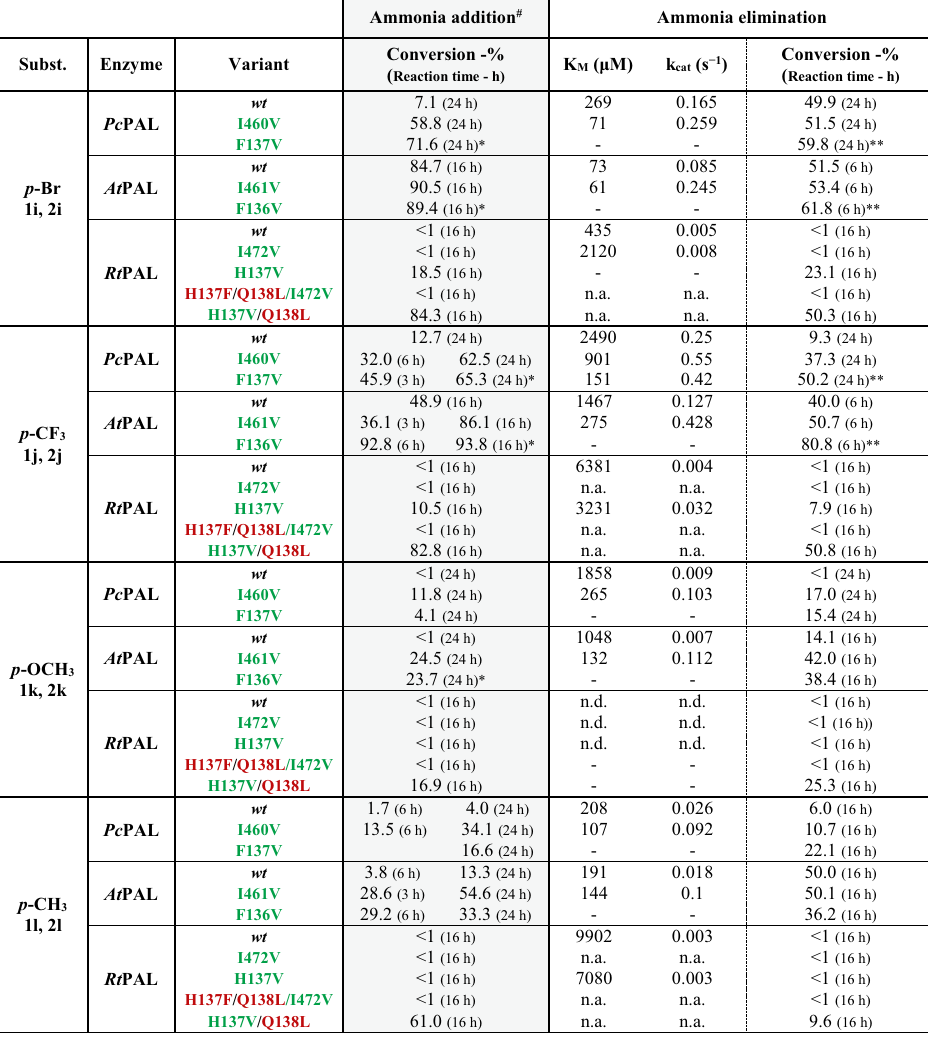
Table 3. Activity assessment of the different PAL variants within the ammonia addition and ammonia elimination reactions of para -substituted cinnamic acids 2i – l and rac -phenylalanines 1i – l , respectively. n.d. not determinable, during enzyme kinetics the non-linear range of the Michaelis–Menten curve was not obtained using substrate concentration allowed by the solubility of the tested compounds; n.a. no activity detected; “-” no determination/measurement was performed. # During the ammonia additions the enantiomeric excess of the obtained l-phenylalanine analogues was also monitored, in all cases ee > 99% have been obtained, with marked exceptions. * 1 . In case of 2i: Pc PAL F137V variant provided l-1i with ee = 97%; At PAL F136V variant provided l-1i with ee = 93%; 2 . in case of 2j : Pc PAL F137V variant provided l-1j with ee = 82%; At PAL F136V variant provided l-1j with ee = 83%; 3 . in case of 2k : At PAL F136V variant provided l-1k with ee = 97%. **During the kinetic resolution-type ammonia eliminations in case of high enantioselectivity the maximal conversion values of rac -phenylalanines is 50%, conversions exceeding this value, support the low enantioselectivity of the